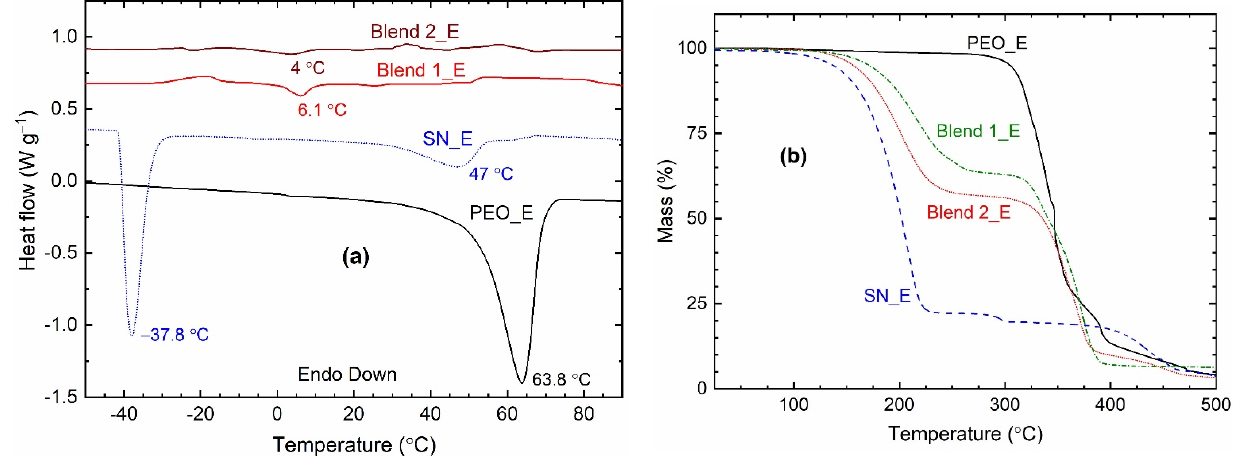
Figure 8. ( a ) DSC and ( b ) TGA curves of the solid redox mediators.